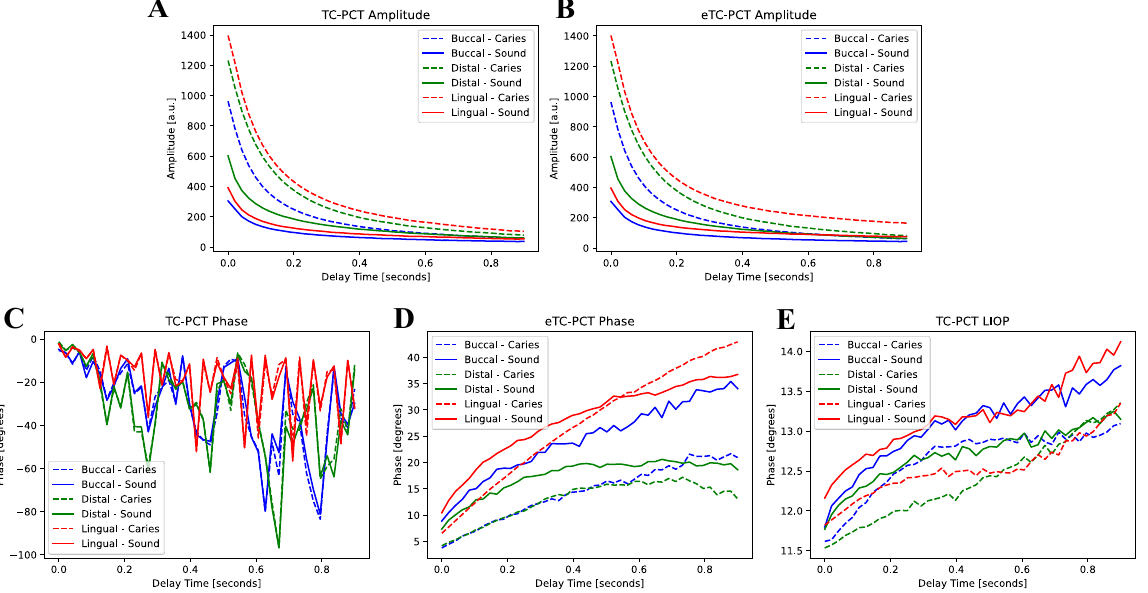
Figure 5. Mean amplitude and phase responses of the caries lesions and sound enamel regions highlighted in Figure 4 for ( A ) TC-PCT amplitude, ( B ) eTC-PCT amplitude, ( C ) TC-PCT phase, ( D ) eTC-PCT phase, and ( E ) TC-PCT LIOP.